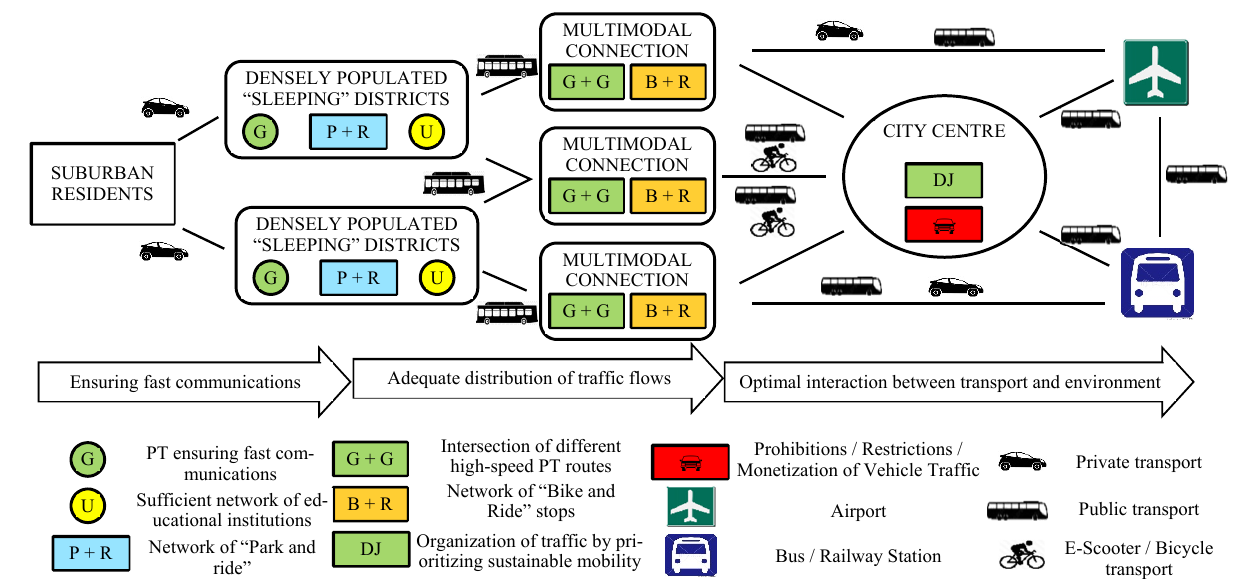
Figure 2. Model for improving the efficiency of the urban transport system (based on [1]). Optimal interaction between transport and the environment . The proposed model would impose strict traffic rules in the city centre. In and around the city centre, priority would be given to sustainable mobility-public transport, bicycles, e-scooters, and